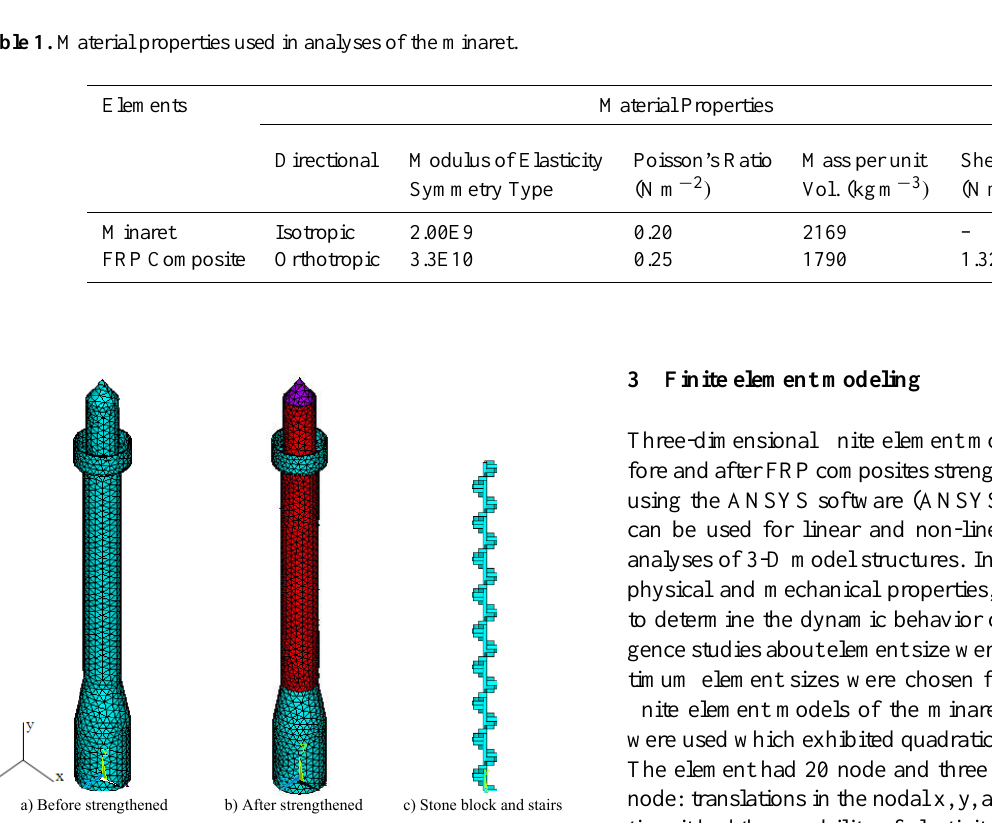
Figure 5 3D finite element models of the minaret before and after FRP composite strengthened including concrete block and stairs A total of 7 natural frequencies of the minaret before and after FRP composite strengthening were obtained with a range between 1.09-12.16 Hz and 1.61-19.07 Hz, respectively. When the first seven modes are examined for both analyses, the first four modes of the minaret are horizontal modes in the z and x directions, the fifth mode is a torsional mode and last two modes are horizontal modes in the z and x directions as seen in Figure 6.